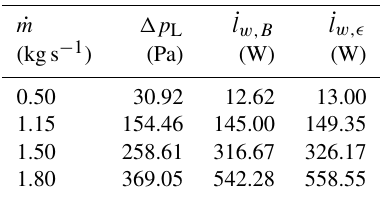
Table 3. Energy balance check for simulations relative to the pro- posed geometry cone.